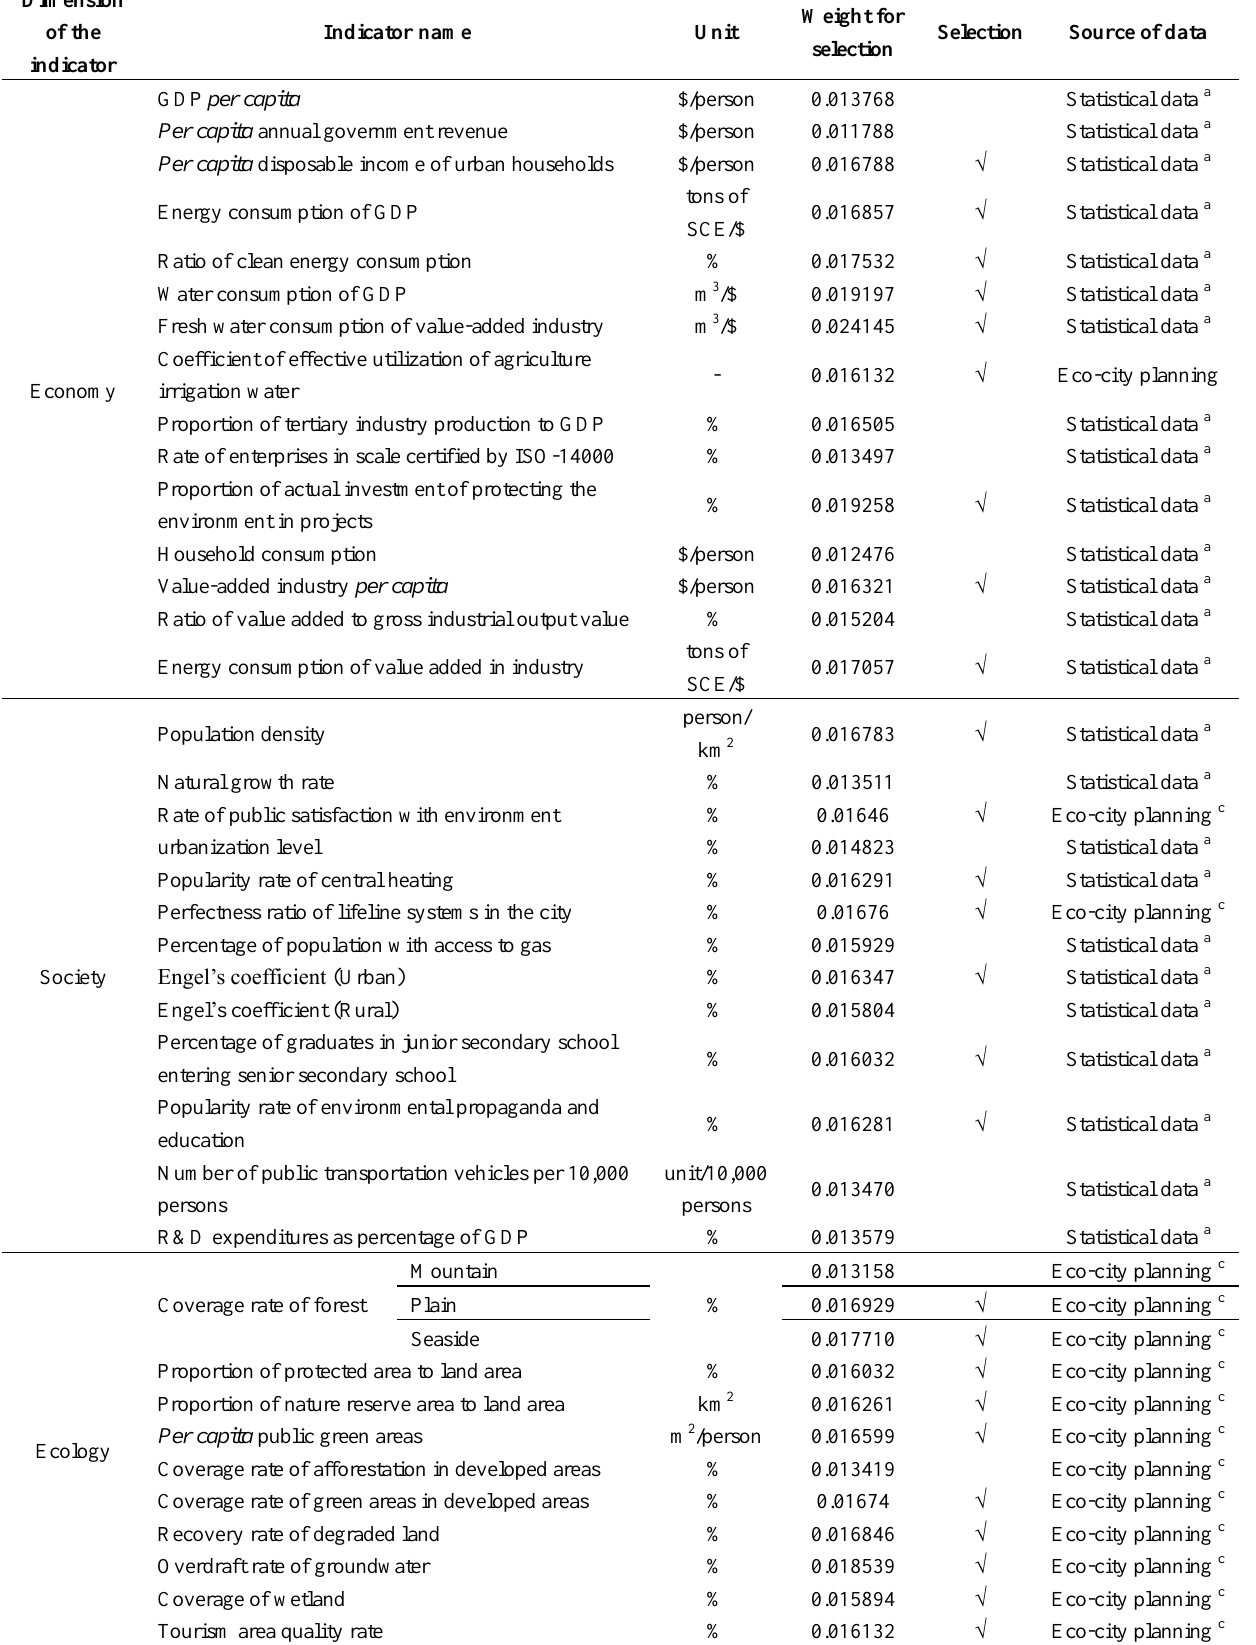
Table 3. Candidate indicators and selection